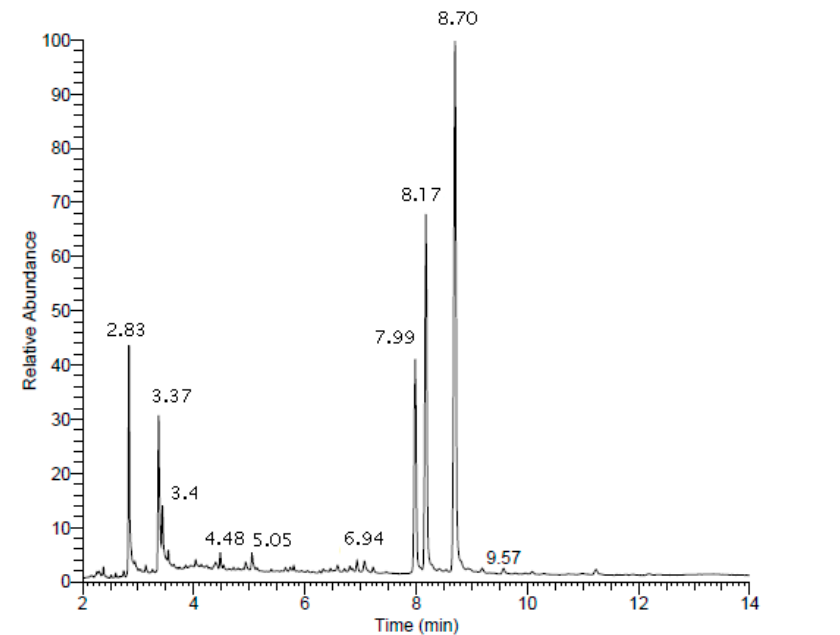
Figure 1. GC-MS chromatographic profile of the hexane extract of A. mollis rhizomes. Table 1. Chemical profile of n-hexane extract from A. mollis L.